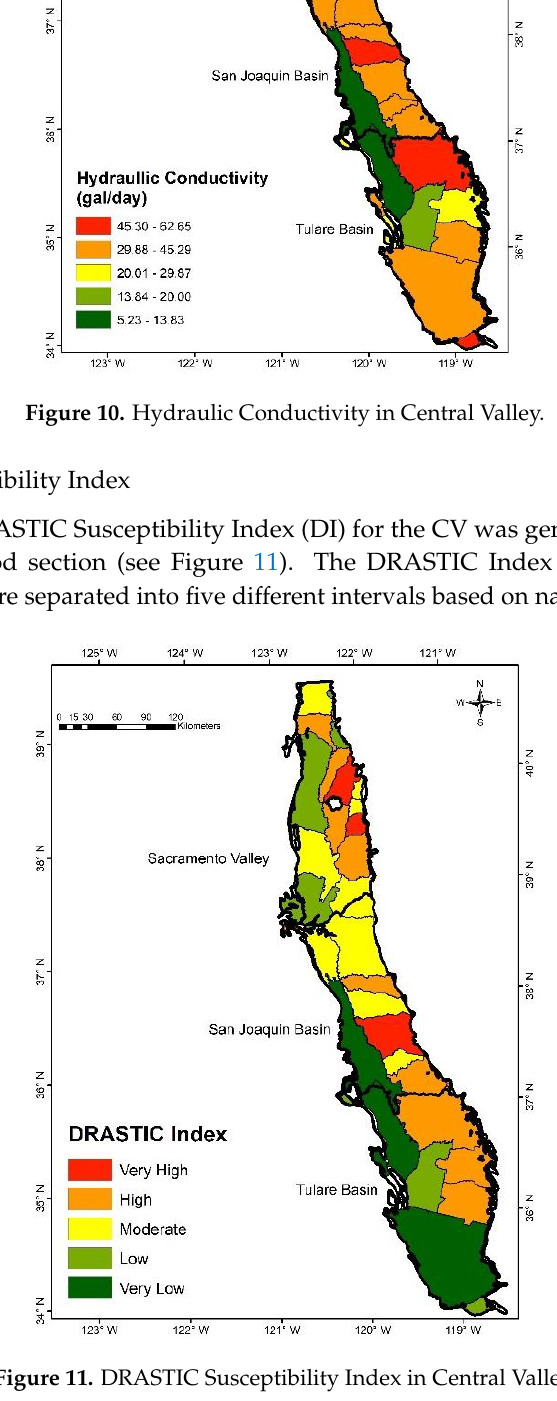
Figure 11. DRASTIC Susceptibility Index in Central Valley